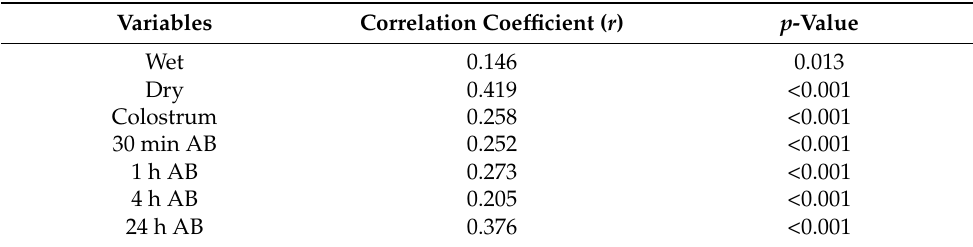
Table 13. Significant correlations between puppies’ weight and their superficial temperature at A thermal window.